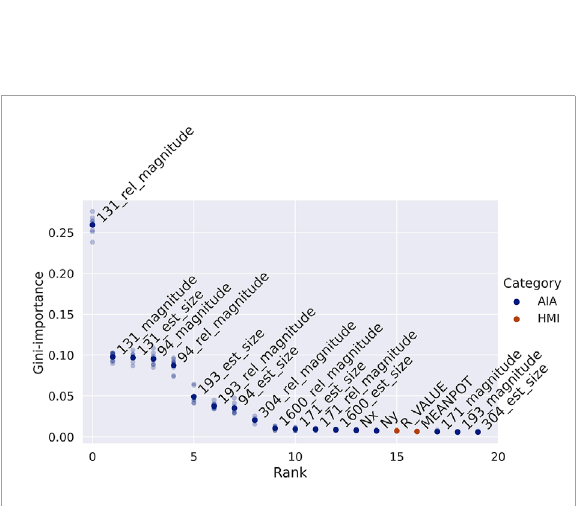
FIGURE 5 Feature importance rankings for the experiment with both AIA and HMI SHARPs features (right). The results from each random seed are shown in faint colors, while the dark colored dots depict the average importance. Only the top 20 features are